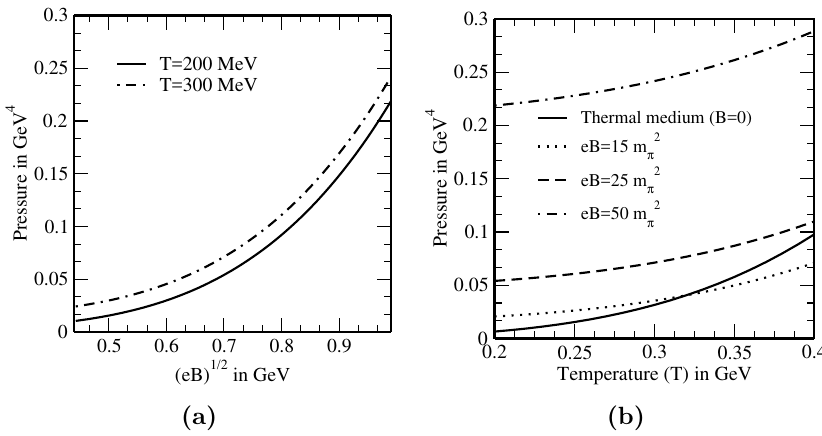
Figure 3 . The variation of pressure of a hot QCD medium for two light (cid:13)avors as a function of p eB at (cid:12)xed temperatures (a) and as a function of T at di(cid:11)erent strong magnetic (cid:12)elds